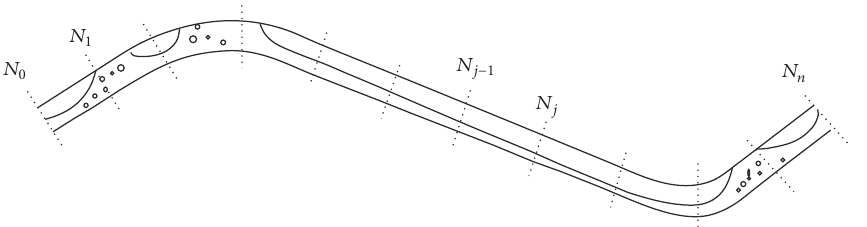
Figure 4: Discretization sketch of gas-liquid two-phase pipeline.